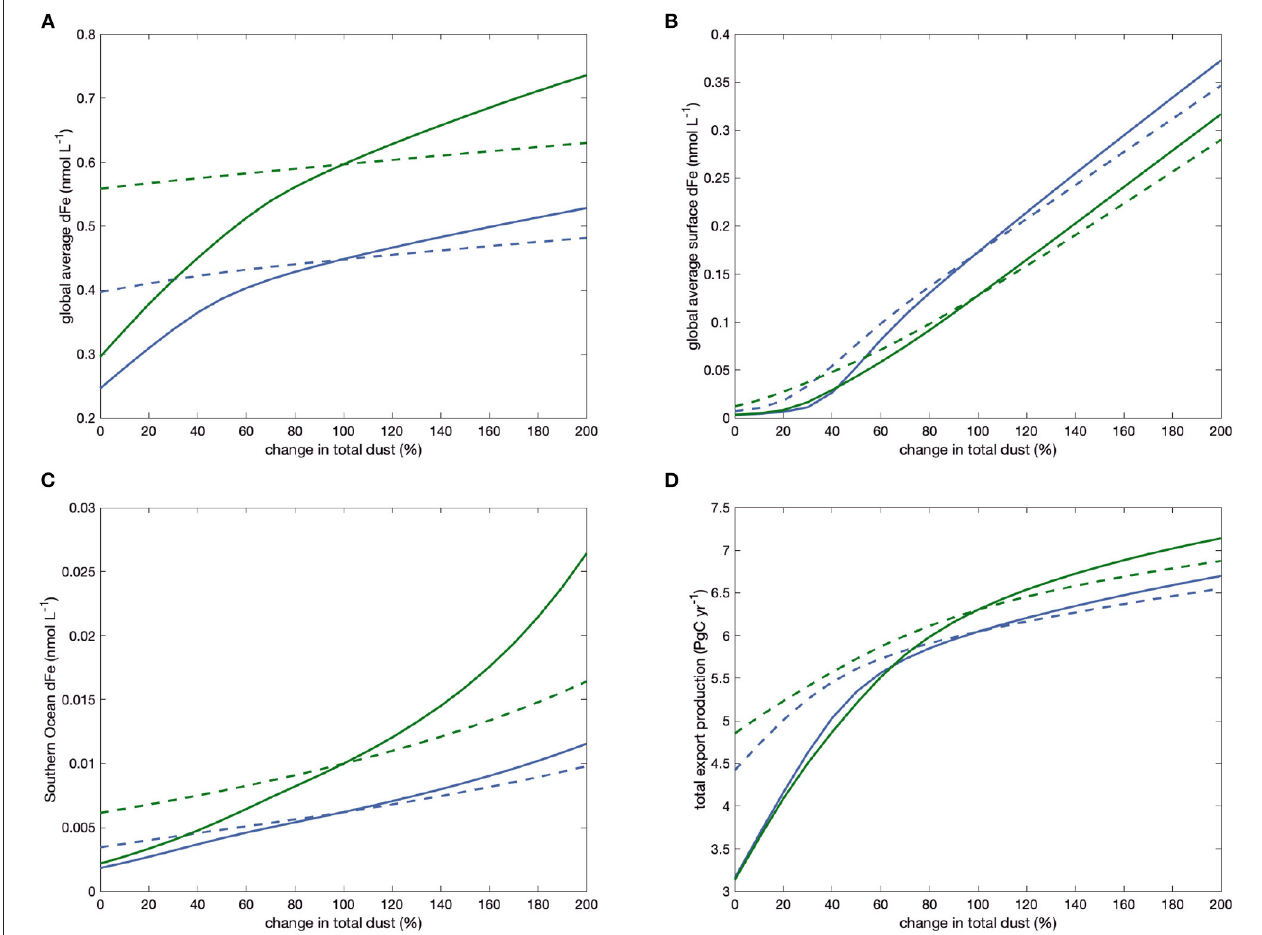
FIGURE 6 | Changes in global average dFe concentration (A) , surface-average dFe (B) , Southern Ocean dFe (C) , and global export production (D) in the model with only one DOC-type ligand, as the magnitude of the total dust is varied, including (solid lines) and excluding (dashed lines) the feedback through changes in ligand concentrations. Blue lines are for model run 1L , green for 1H .